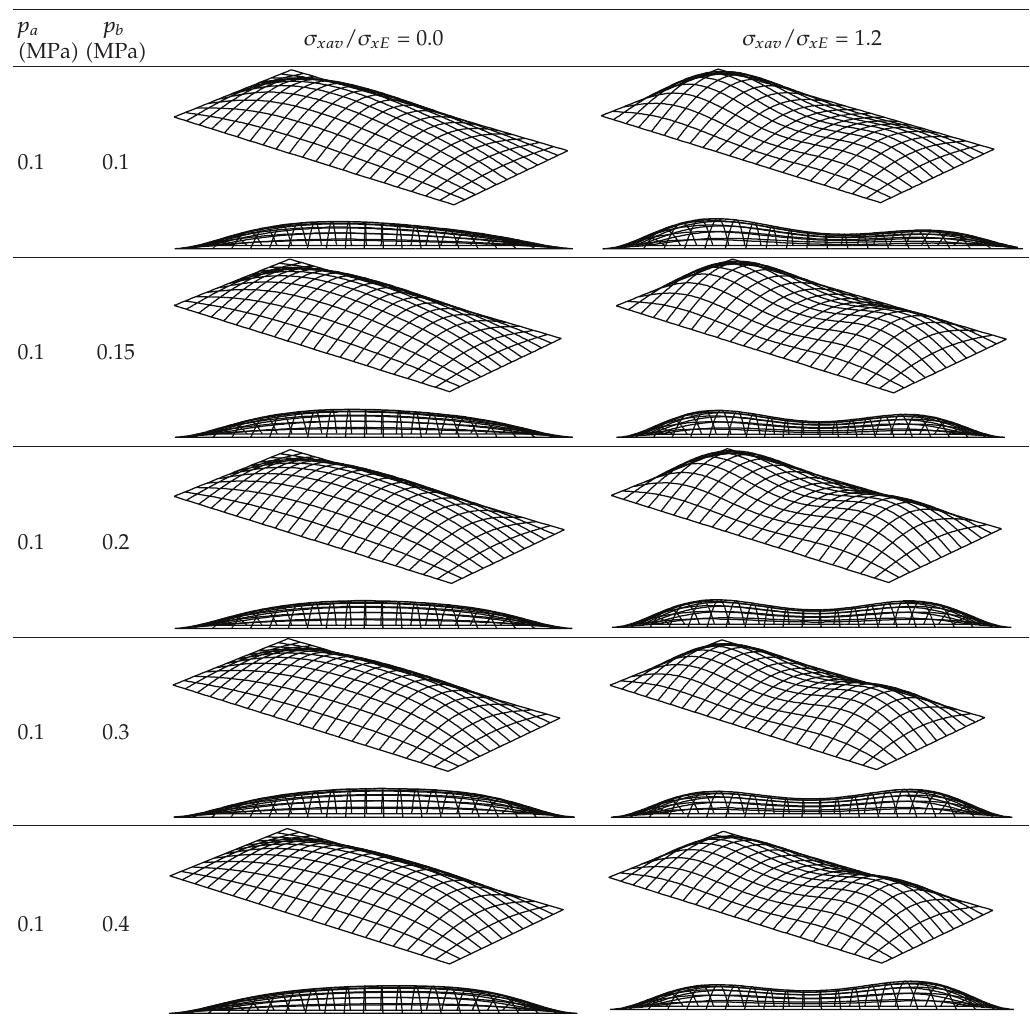
Table 1: Deformed shapes of the plate when M (cid:6)